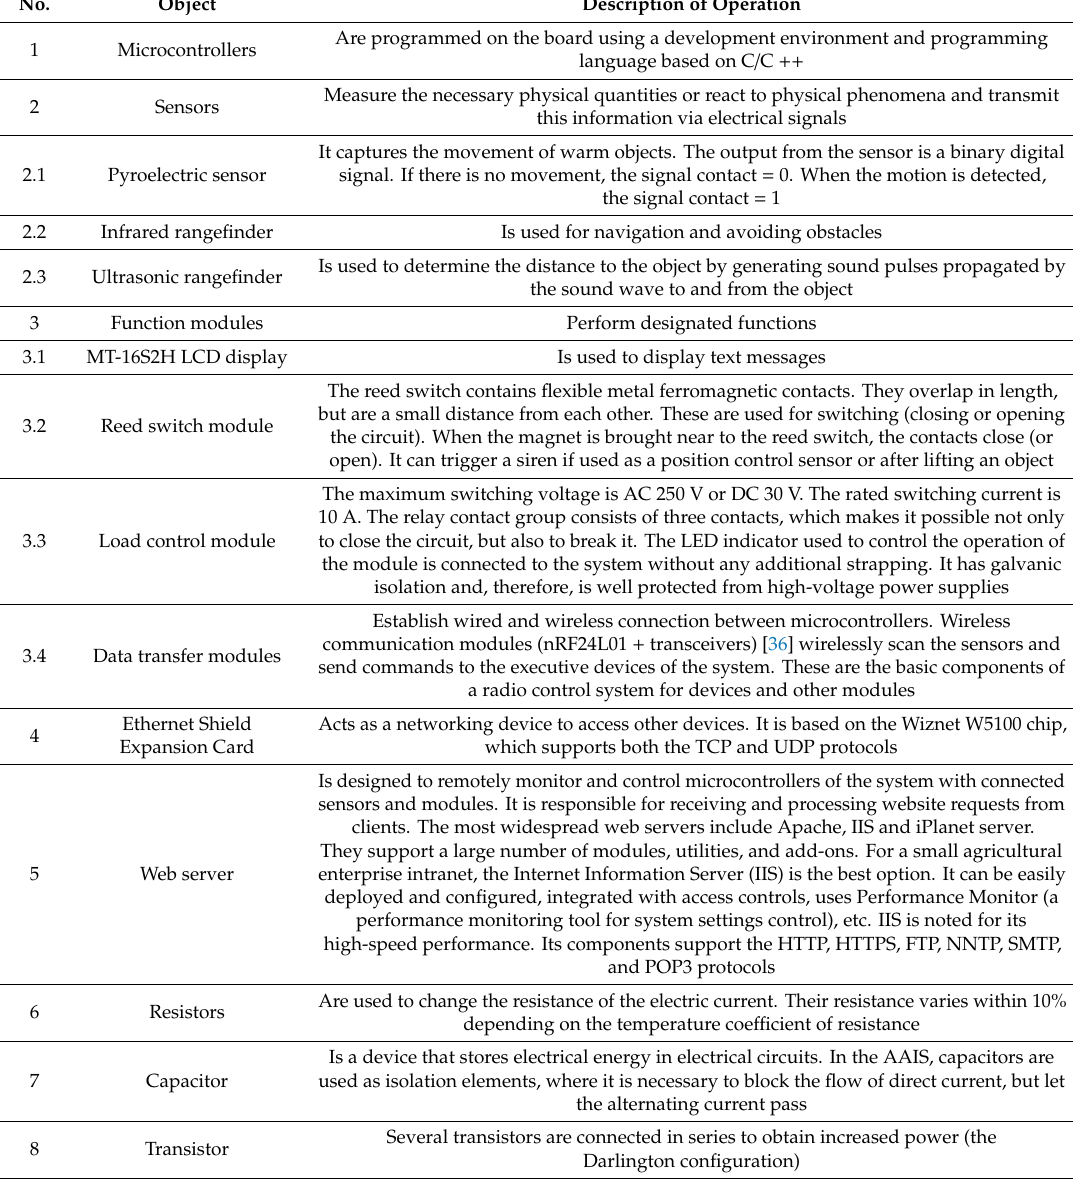
Table 1. Composition and principles of operation of an intelligent automation